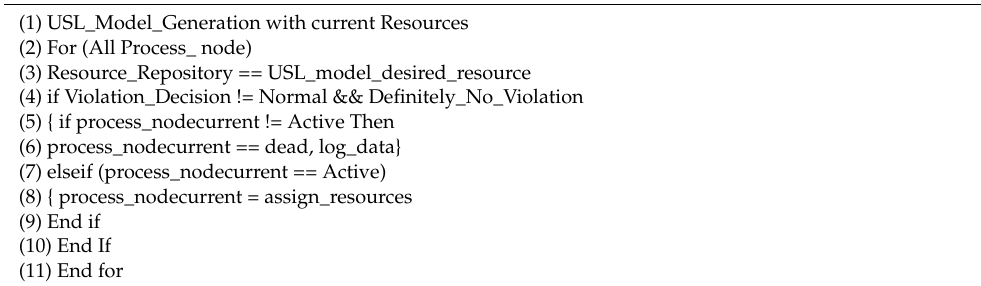
Algorithm 1. Resource Allocation after modelling Universal Scalability